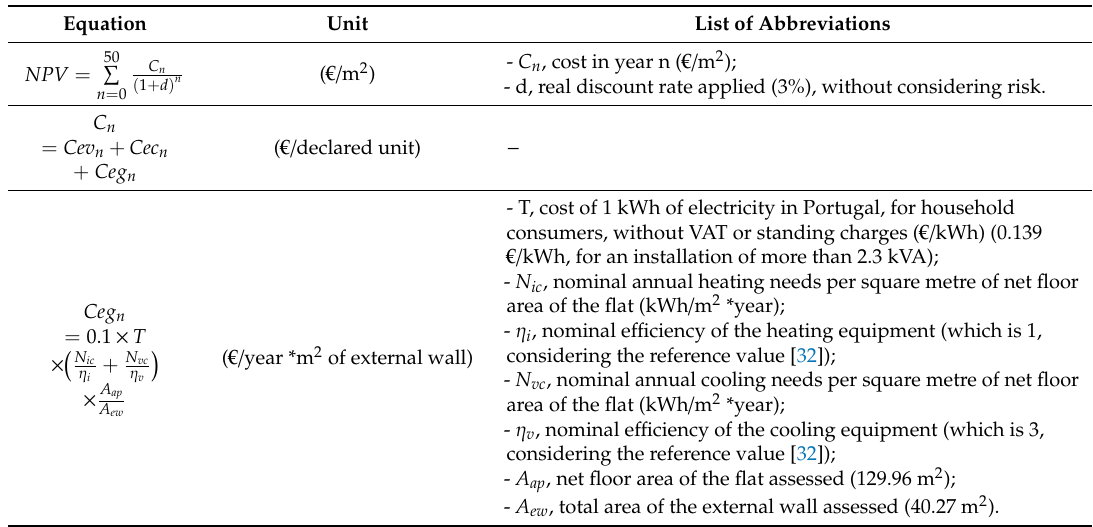
Table 4. Equations used to determine the NPV of each solution. Equation List of